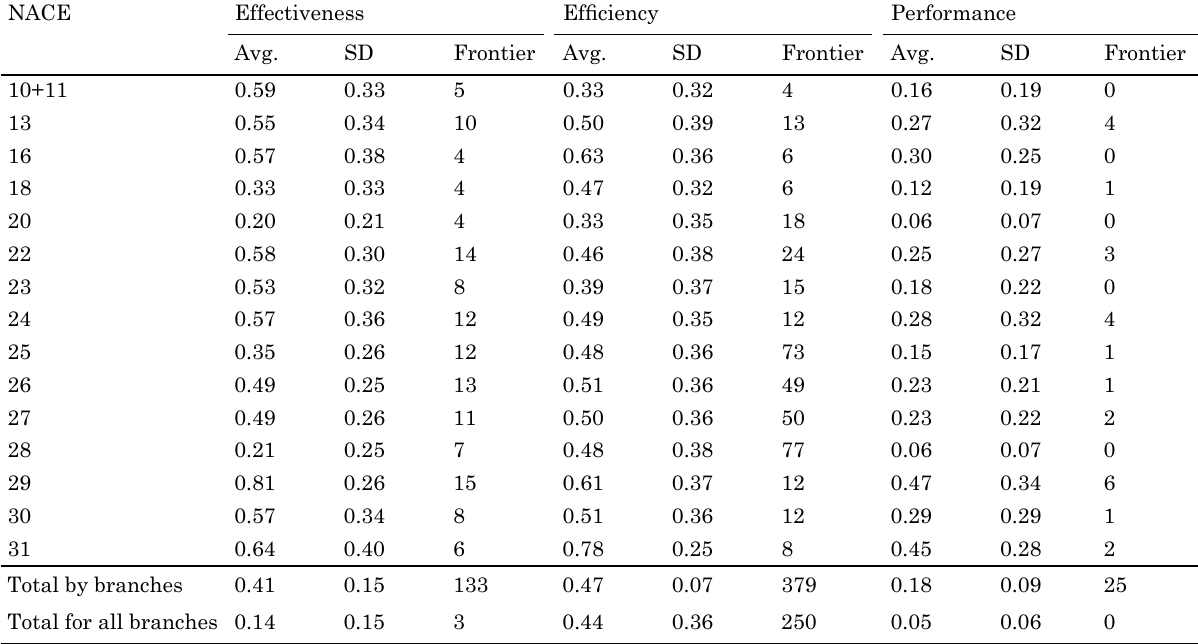
Table 2. Scores of effectiveness, efficiency and performance by branches nACE Effectiveness Efficiency Performance